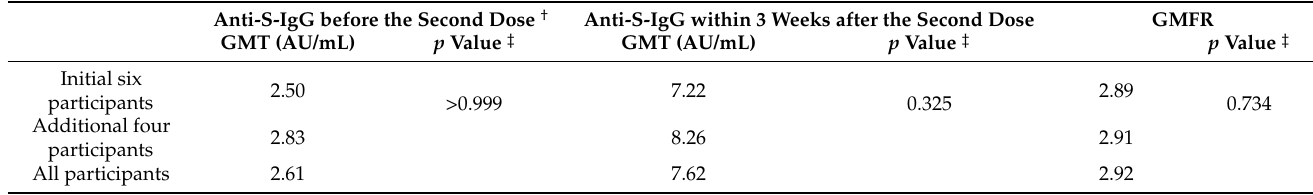
Table 2. Changes in anti-spike immunoglobulin G titers after vaccination.